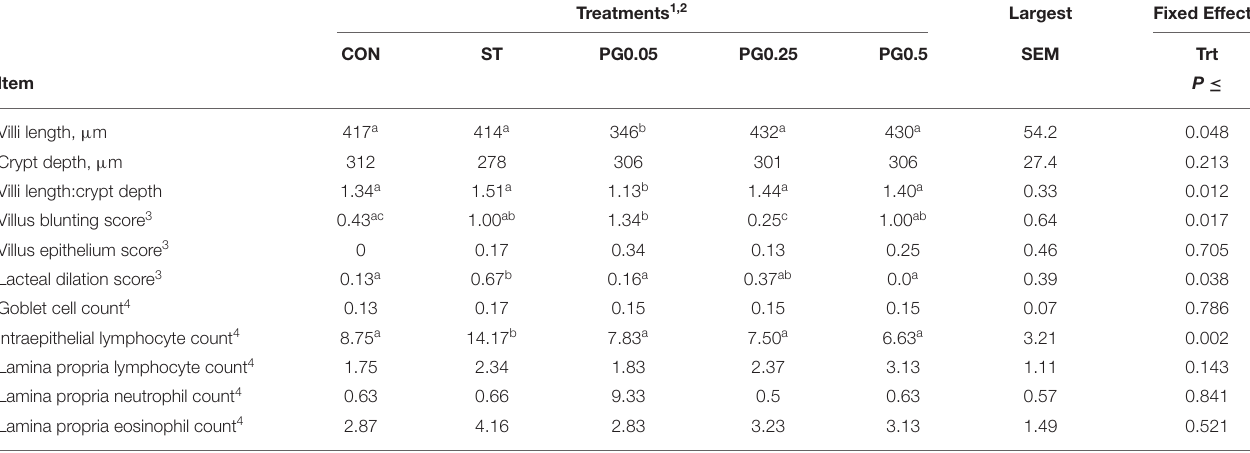
TABLE 5 | Ileum histopathological effects of a ceramic particle fed to pigs after a S. enterica serotype typhimurium infection. Treatments 1,2 Largest Fixed Effects CON ST